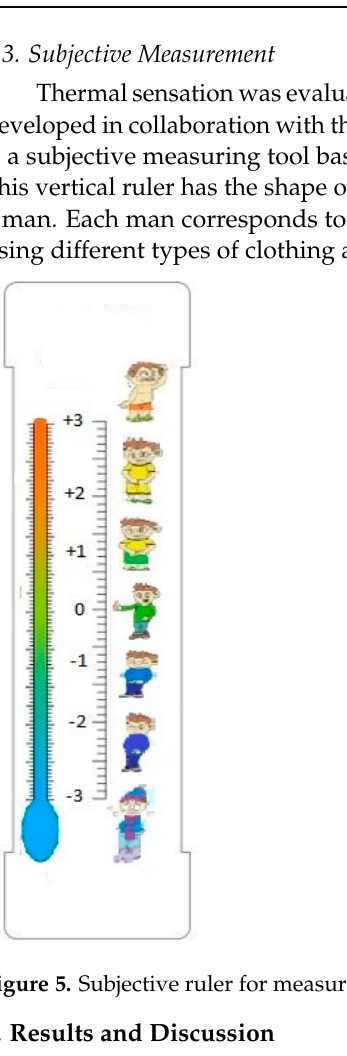
Figure 4. Thermal microclimate station.